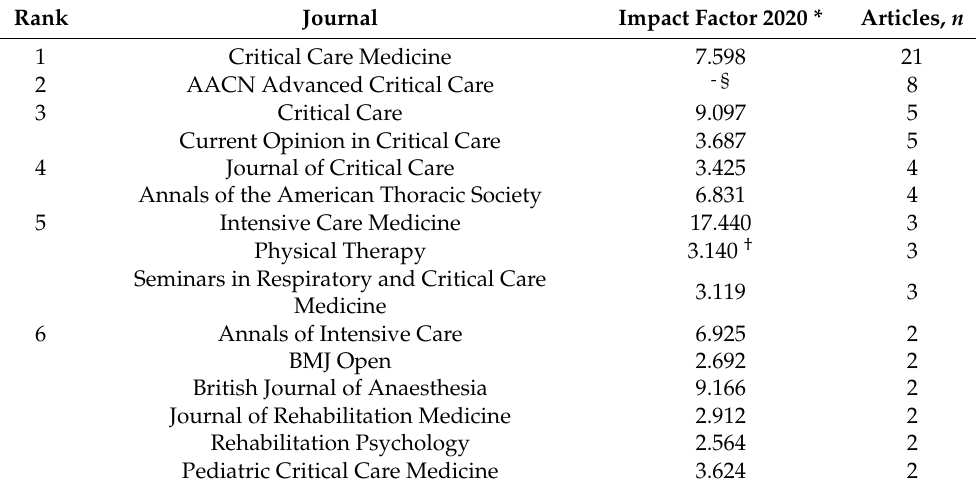
Table 4. Publishing journals of the 100 most-cited articles on post-intensive care syndrome.